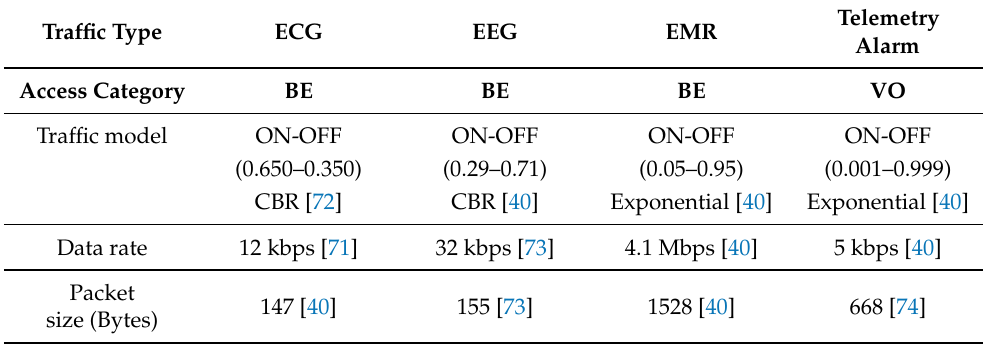
Table 6. Traffic characteristics in the simulation